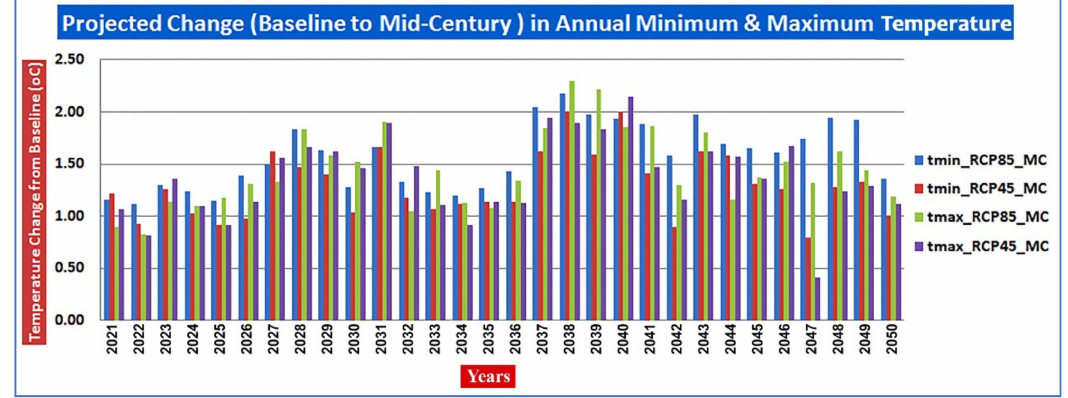
Figure 10. The variability of projected average annual maximum and minimum temperatures for the multimodel ensemble RCM (RCP 4.5 and RCP 8.5) in MC.